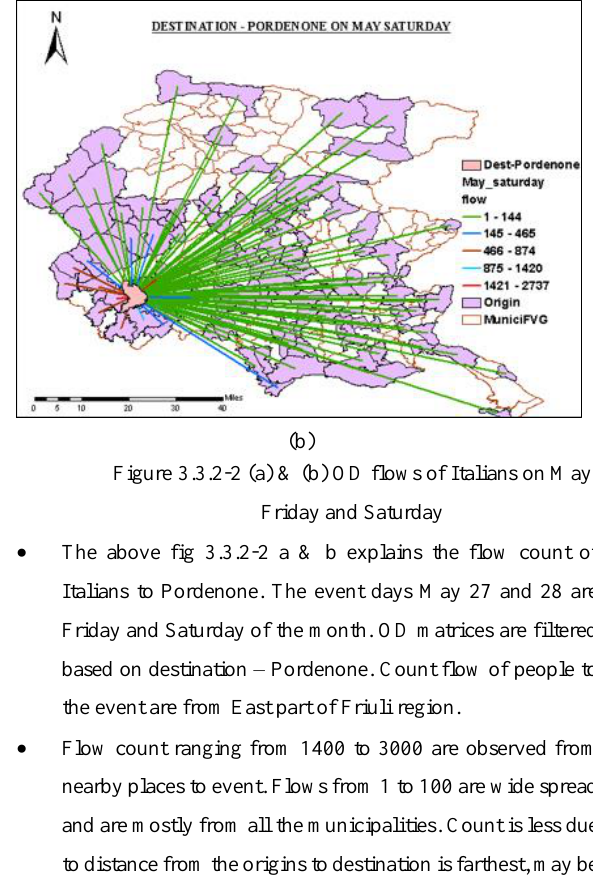
Figure 3.3.2-2 (a) & (b) OD flows of Italians on May